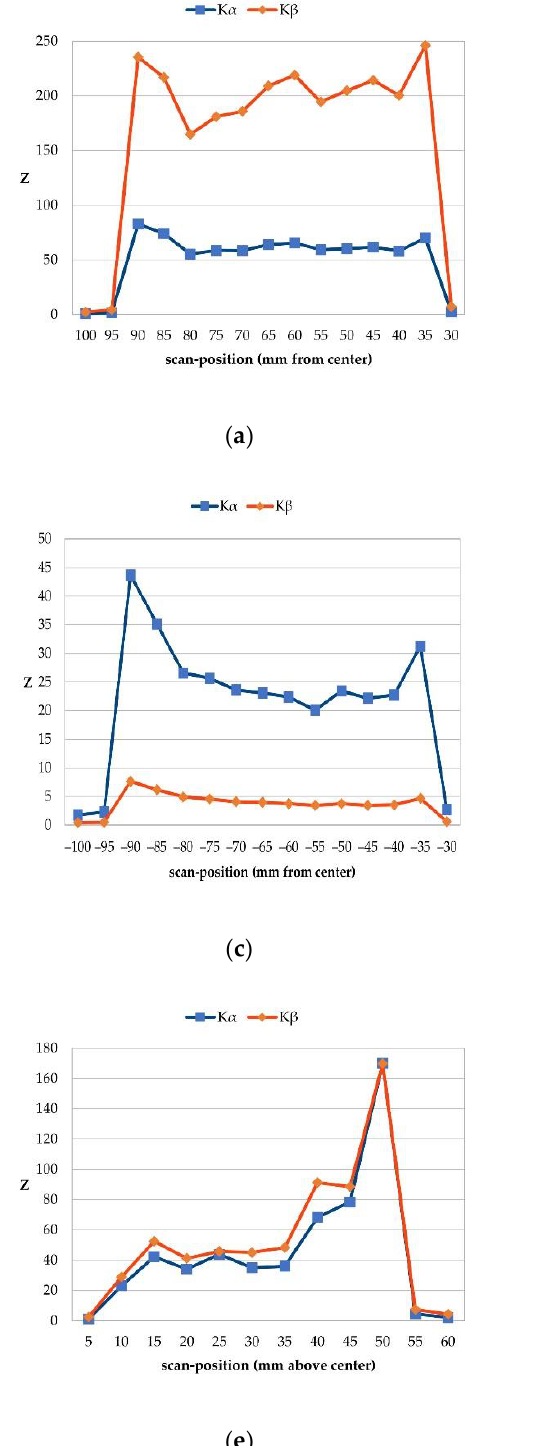
Figure 8. Signal significance (Z) after spatial filtering for both K α and K β fluorescence at all scanning positions in abdominal slice: ( a ) significance per position at right colon when scanning from front; ( b ) significance per position at left colon when scanning from front; ( c ) significance per position at right colon when scanning from back; ( d ) significance per position at left colon when scanning from back; ( e ) significance per position at both right and left colon (overlapping) when scanning from side. Spikes at edges of any graph indicate higher amount of gold in beam volume, hence they show that here, colon walls are hit straightly. Subsequently, uneven curves do not arise from uncertainties in significance (which is smaller than marker size), but rather from varying scanning conditions at different scanning points, such as different tissues lying in scanning